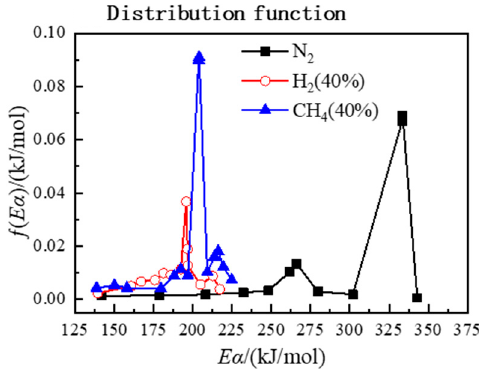
Figure 8. Activation energy, E α , distribution density curve.